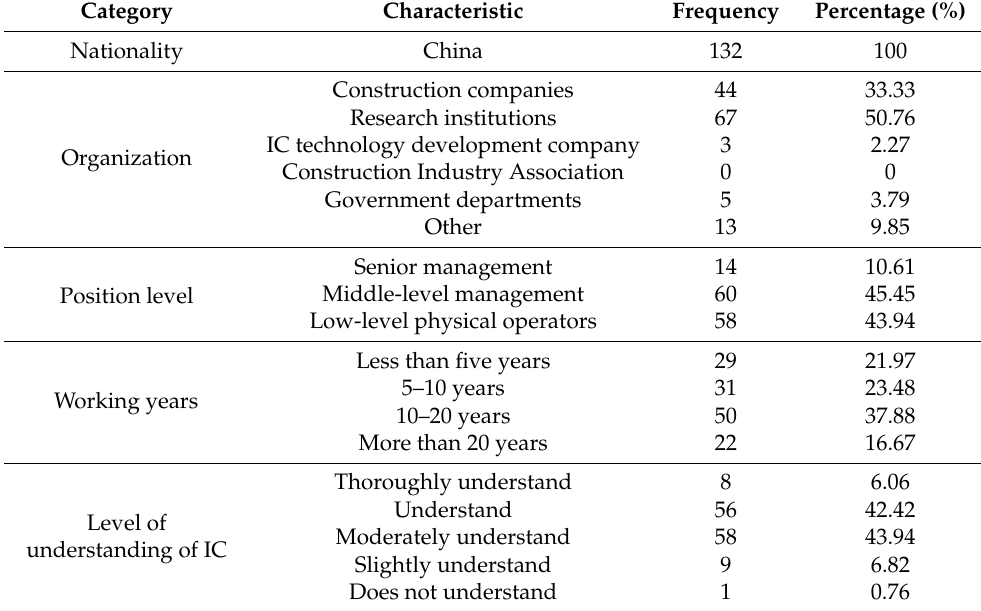
Table 4. Respondent’s